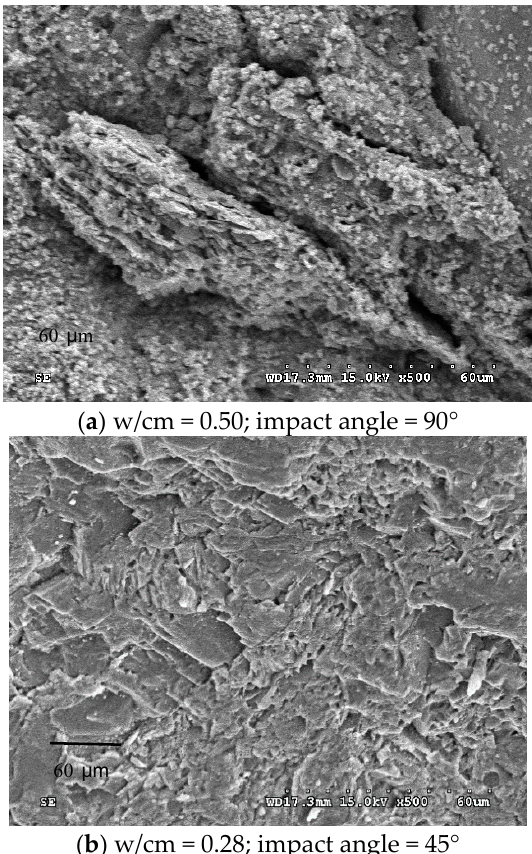
Figure 6. SEM images of worn concrete surface after impact test; scale: 60 μ m.